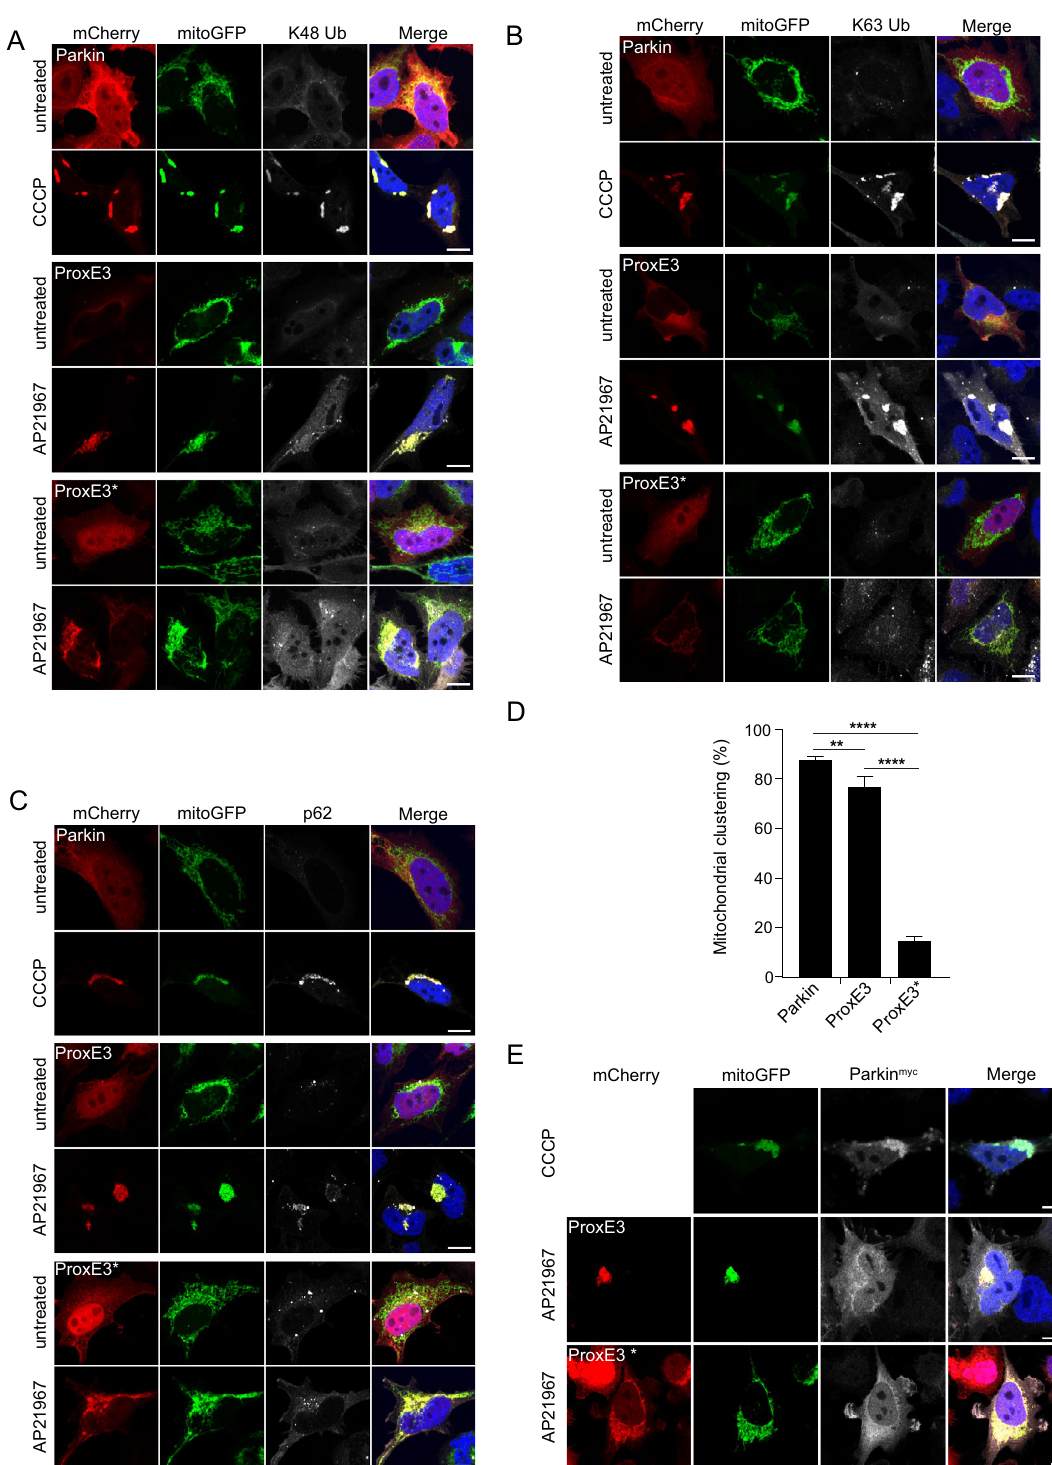
Figure 4. K63-linked ubiquitin chains are sufficient to induce p62 recruitment and mitochondrial sequestration. Representative confocal images of HeLa cells stably expressing mitoGFP-Sub, transfected with mCherry-tagged Parkin, ProxE3 or the catalytically inactive ProxE3* and treated for 16 h with 10 µM CCCP or 400 nM AP21967. Cells were not treated with proteasome inhibitor MG132. Cells were fixed and stained using a K48-linkage-specific ubiquitin antibody ( A) , a K63-linkage specific ubiquitin antibody ( B ), an anti-p62 antibody ( C ). Magnified regions are indicated. Scale bar: 10 µm. ( D ) Quantification of the percentage of cells displaying perinuclear sequestration of their mitochondria. Data shown represent the mean ± SD of three independent experiments. For each experiment 100 cells were scored. ****p < 0.0001, ***p < 0.001, **p < 0.01 (one-way ANOVA, Sidak’s multiple comparison test). ( E ) Representative confocal images of HeLa cells stably expressing mitoGFP-Sub transiently transfected with Parkin myc or co-transfected with Parkin myc and mCherry-ProxE3 or catalytically inactive mCherry-ProxE3*. Cells were treated for 16 h with 10 µM CCCP or 400 nM AP21967 and stained using an anti-myc antibody. Scale bar: 10